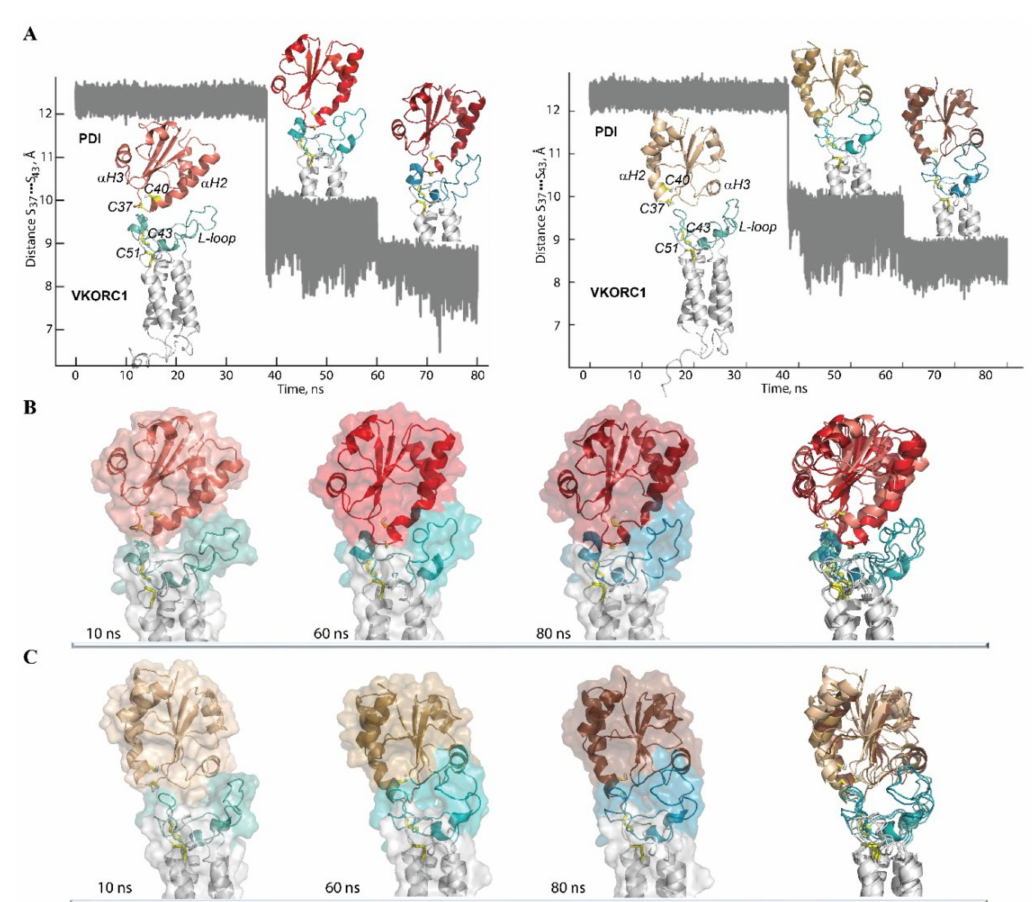
Figure 11. Modelling of human PDI–VKORC1 complex. ( A ) MD simulations of 3D model PDI–VKORC1 complexes were performed, with gradually diminished distance (from 12.5 to 8.0 Å) between the sulphur (S) atoms of C37 from PDI and of C43 from the L-loop of hVKORC1. PDI has two orientations with respect to VKORC1, with F1 ( Model 1 , left) and F2 ( Model 2 , right) positioned above the middle of the L-loop surface. Both models of the PDI–VKORC1 complex are shown as snapshots taken at t = 10, 60 and 80 ns, with different S · · · S distances. The reference residues and fragments are labelled. ( B , C ) Conformations of the PDI–VKORC1 complex, with two different PDI orientations, chosen at t = 10, 60 and 80 ns, and their superposition at all three times. In ( A – C ), the proteins are depicted as ribbons or as ribbons and surfaces and are distinguished by colour: a red palette was used for PDI and a cyan palette for hVKORC1, both nuanced by the tonality from light to dark to distinguish the conformations chosen at t = 10, 60 and 80